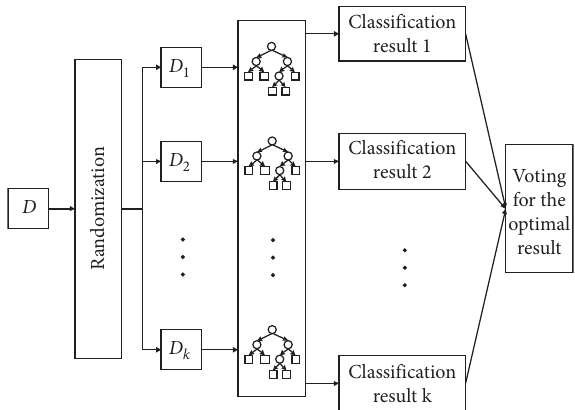
Figure 2: The operating principle of random forest.